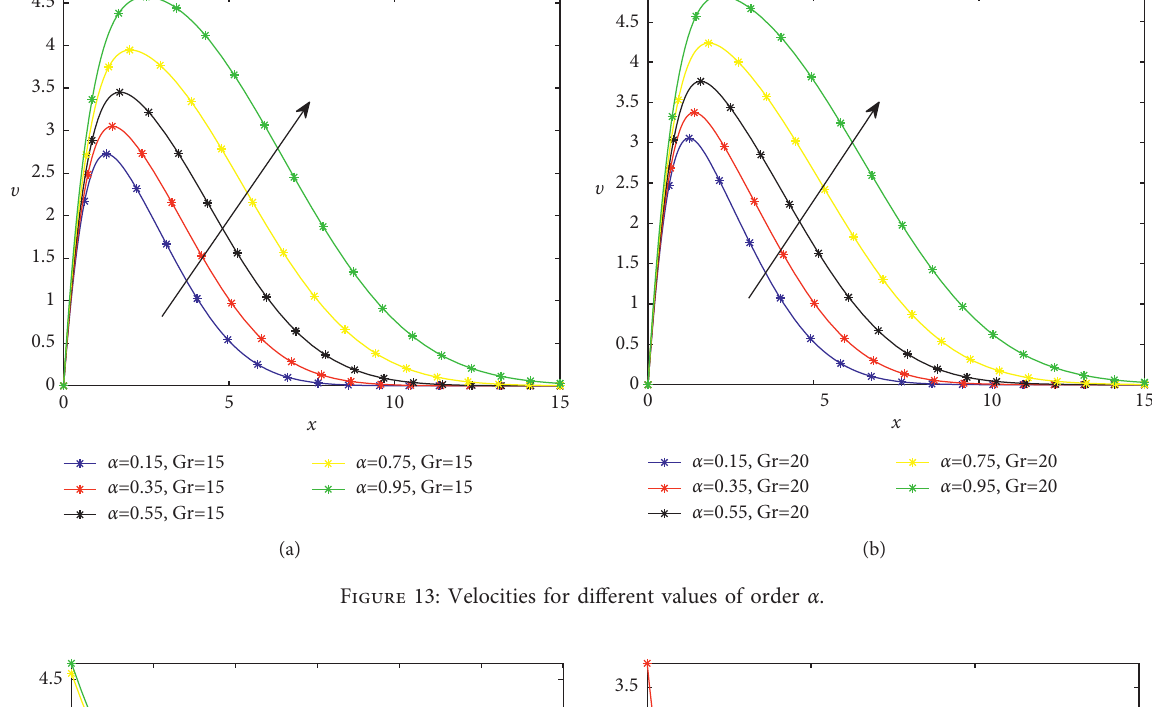
Figure 13: Velocities for different values of order α .